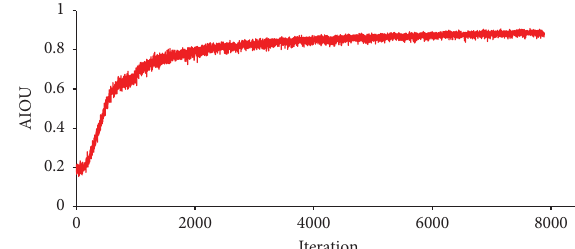
Figure 13: The iterative convergence process of the AIOU curve for the improved RDCNN training.